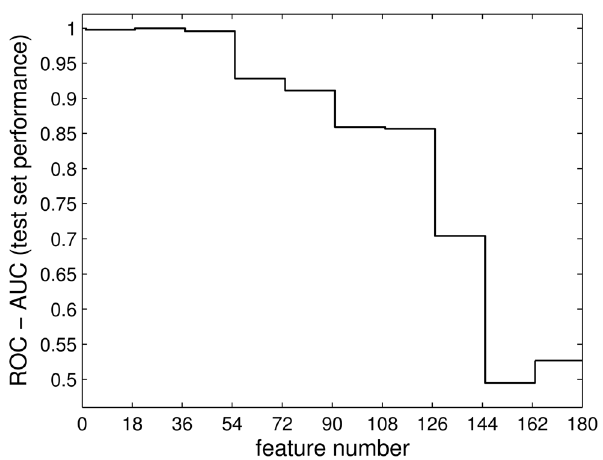
Figure 9. Test set performance (AUC of ROC) for the GMLVQ system restricted to subsequent subsets of 18 features which are ordered according to diagonal relevance L ii . The AUC deteriorates from values close to 1 for highly relevant features to AUC & 0 : 5 when using 18 features of low relevance.